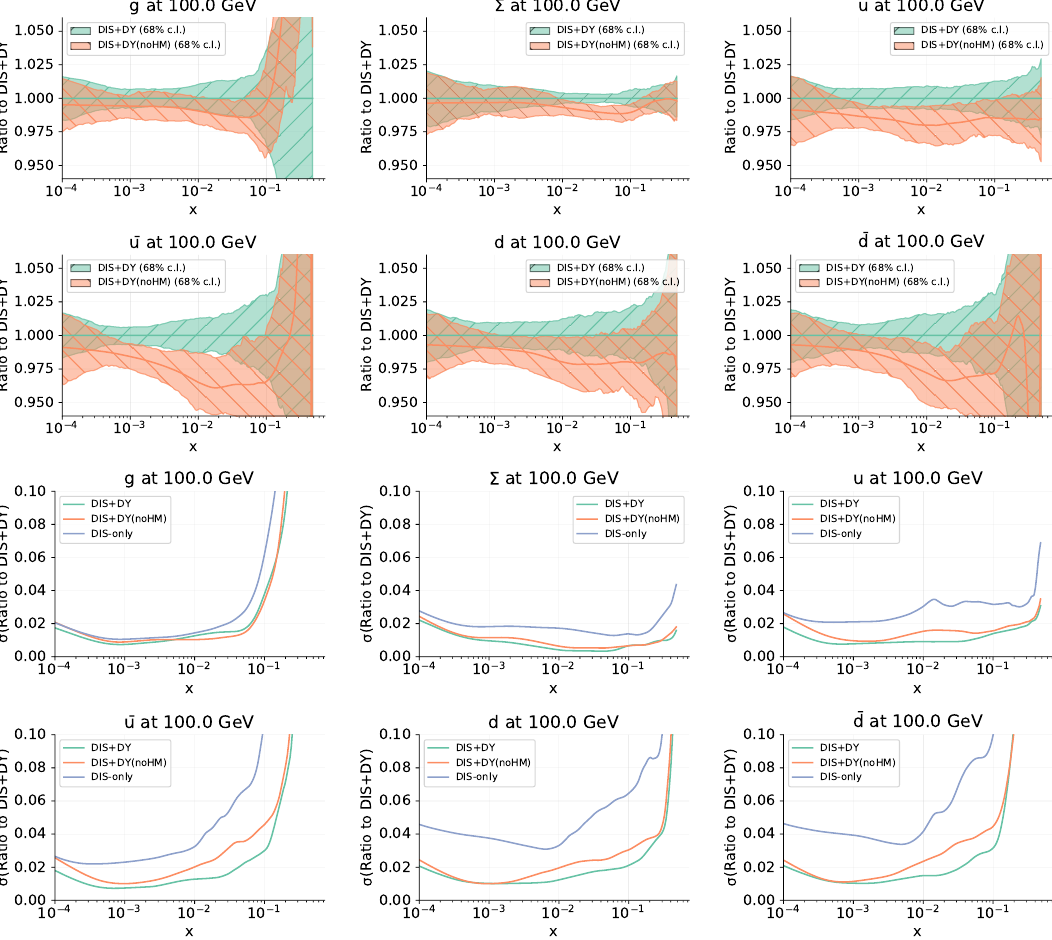
Figure 3 . Comparison between the baseline SM PDF set of this work, labelled “DIS+DY”, with the corresponding fit without high-mass DY data. We show results at Q = 100 GeV for PDFs normalised to the central value of the baseline (upper) and for the relative PDF uncertainties (lower panels). In the latter case, we also display the PDF uncertainties from the DIS-only fit.